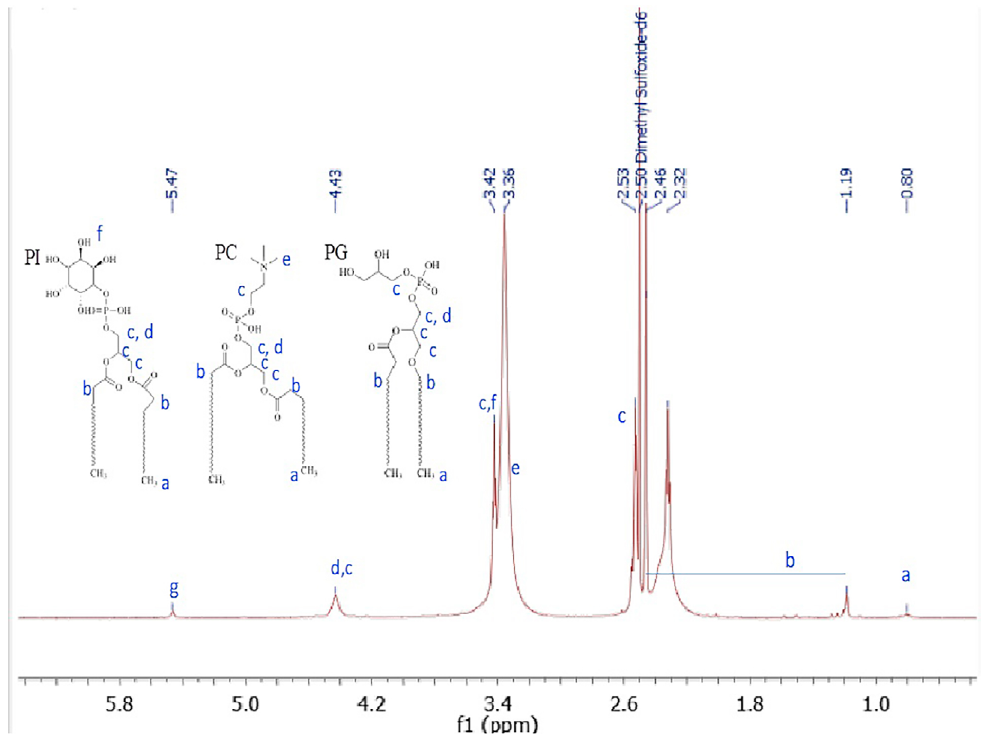
Figure 2- Spectrogram of lipids (ECL) extracted from C. albicans biofilm. Resonance was performed from a lyophilized sample of C. albicans lipids previously extracted from six biofilms (n=6). The sample was resuspended in DMSO for ¹H-NMR analysis. (a) CH3 residues. (b) CH 2 residues from methylene protons of aliphatic chains –(CH 2) n, β-methylene protons of carbonyl –OCO−CH2−CH2−, and methylene protons in the α -position of –CH 2−CH=CH− double bonds. (c) CH2 CO residues. (d) Methyl protons of charged nitrogen